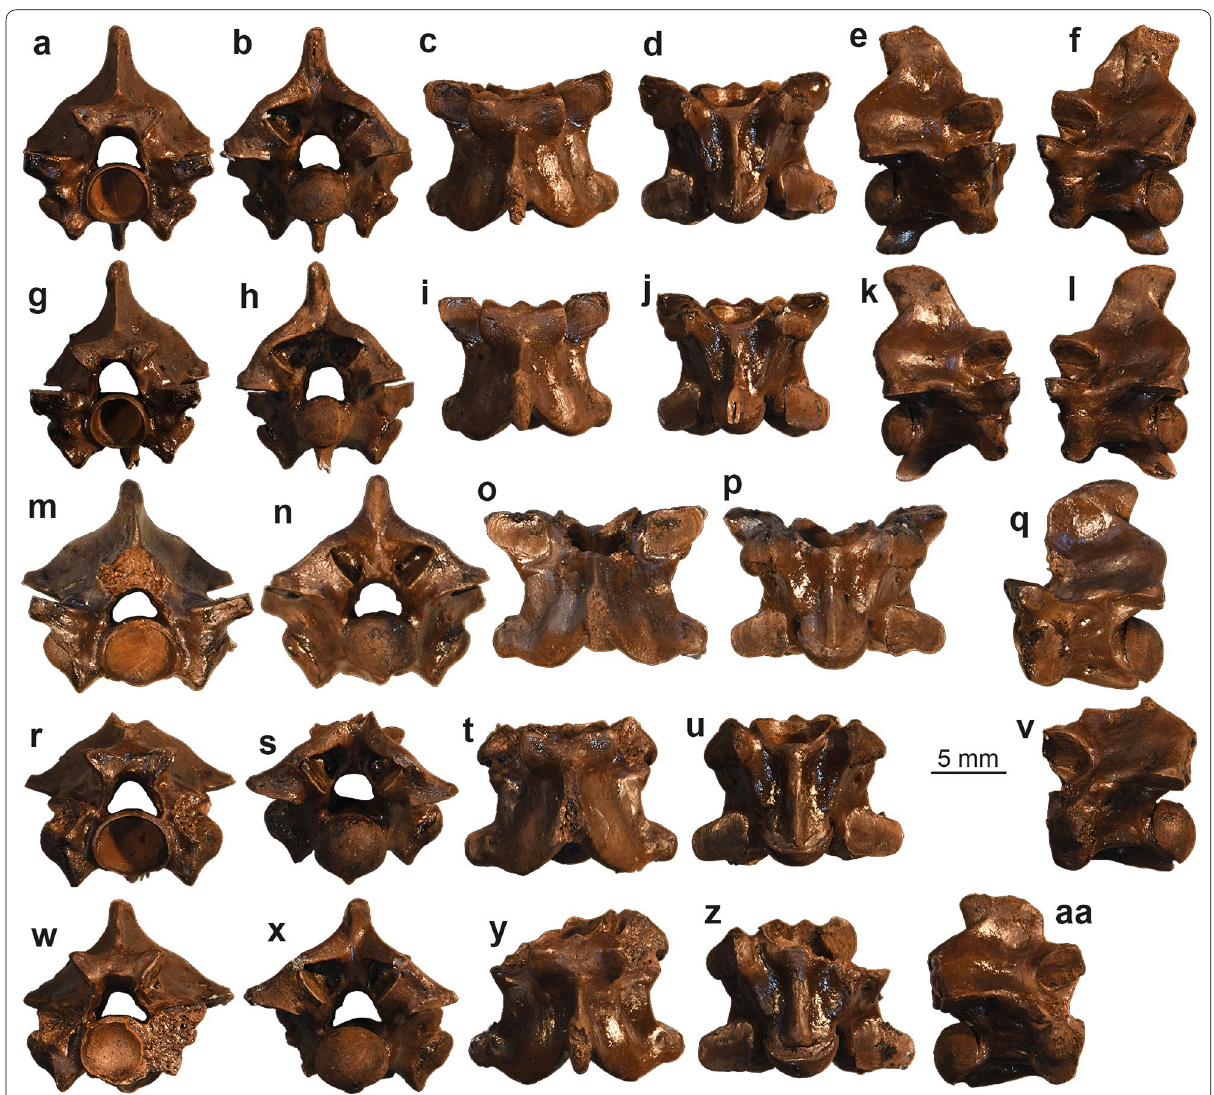
Fig. 54 Eoconstrictor cf. fischeri from quarry IX, Geiseltal: a–f anterior trunk vertebra (GMH IX-696b-1952) in anterior ( a ), posterior ( b ), dorsal ( c ), ventral ( d ), right lateral ( e ), and left lateral ( f ) views; g – l anterior trunk vertebra (GMH IX-696c-1952) in anterior ( g ), posterior ( h ), dorsal ( i ), ventral ( j ), right lateral ( k ), and left lateral ( l ) views; m – q anterior mid-trunk vertebra (GMH IX-696f-1952) in in anterior ( m ), posterior ( n ), dorsal ( o ), ventral ( p ), and left lateral ( q ) views; r – v posterior mid- or posterior trunk vertebra (GMH IX-696d-1952) in anterior ( r ), posterior ( s ), dorsal ( t ), ventral ( u ), and left lateral ( v ) views; w – aa posterior trunk vertebra (GMH IX-696a-1952) in anterior ( w ), posterior ( x ), dorsal ( y ), ventral ( z ), and right lateral ( aa )